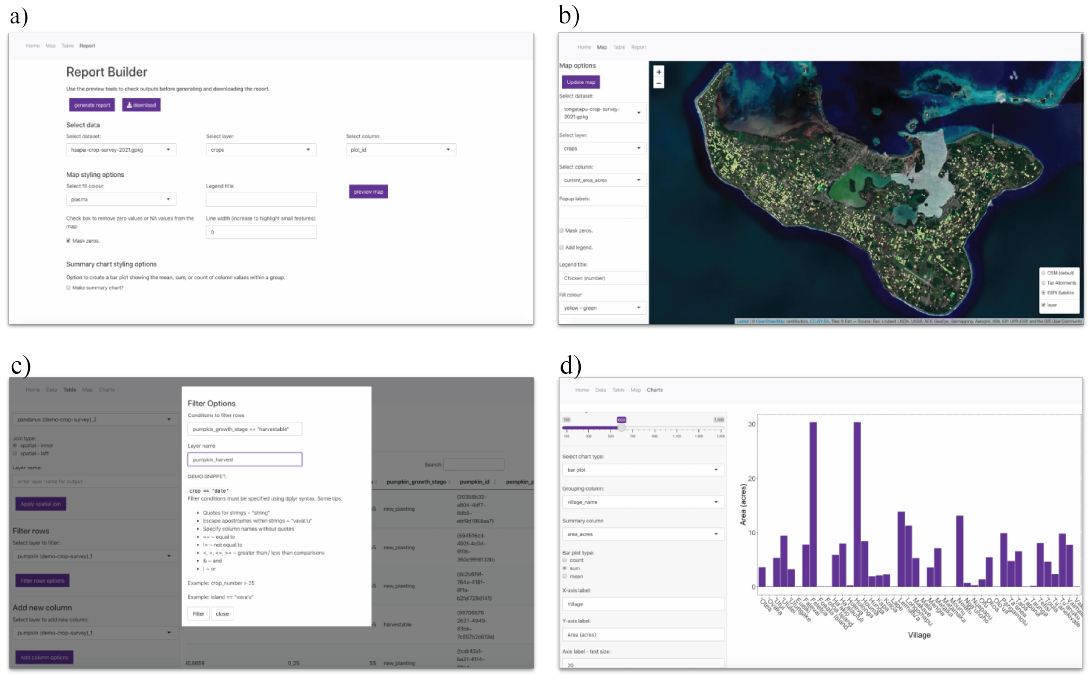
Figure 4. Report building interface (a), viewing QFieldCloud spatial layers on web maps in maplandscape-view (b), example performing GIS operations on QFieldCloud data in web browser in maplandscape , example of maplandscape’s chart builder tools (d).